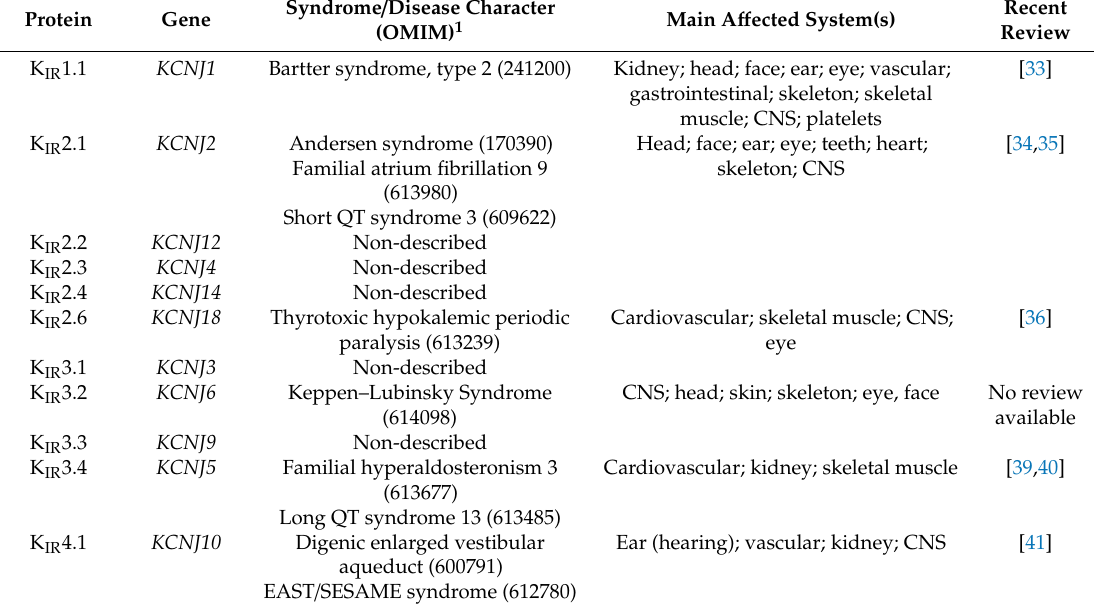
Table 1. Human diseases associated with abnormal K IR channel